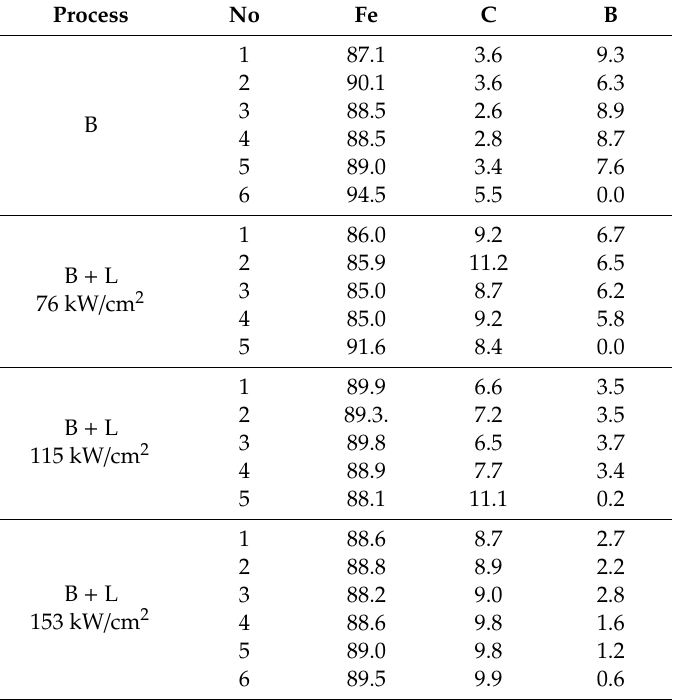
Table 4. Results of EDS point marked in Figures 2a and